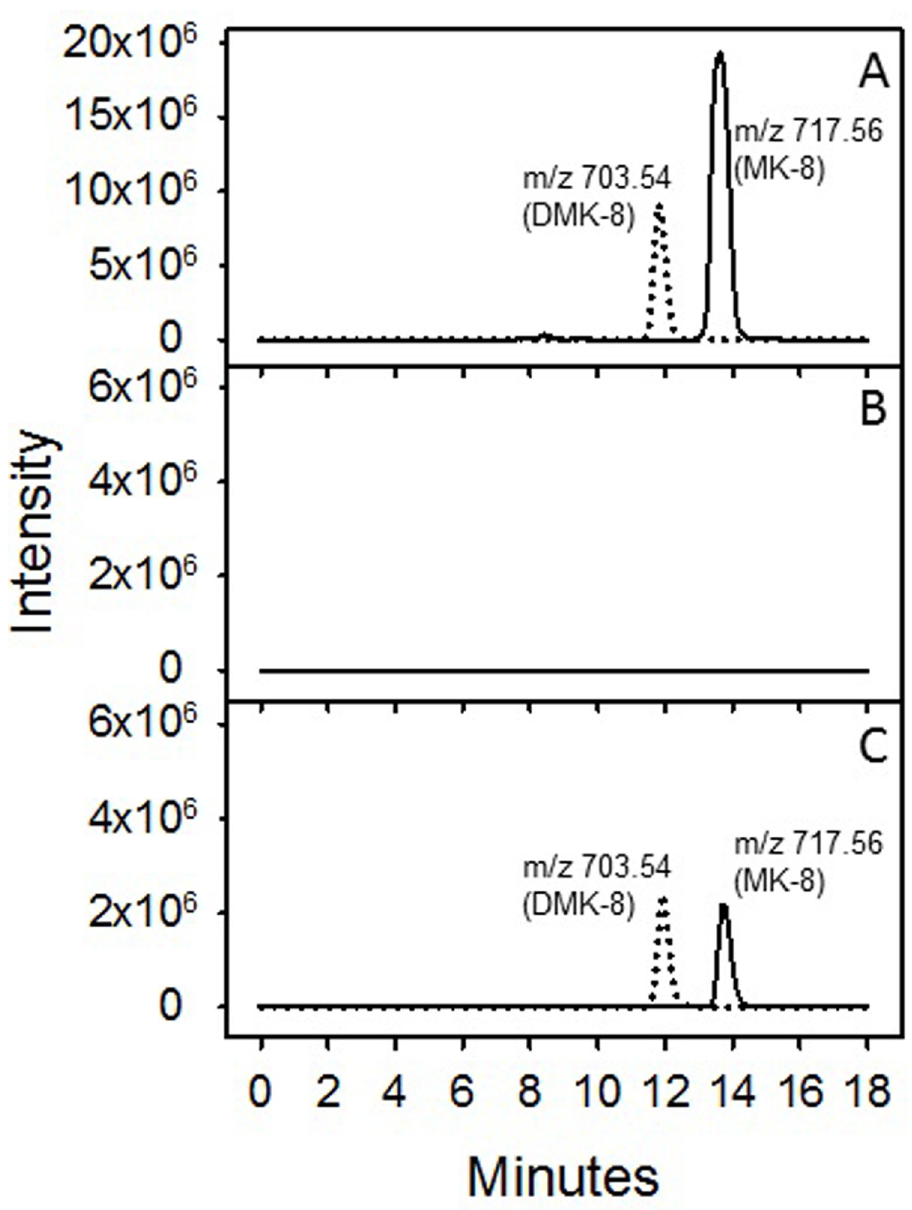
Fig 2. LC/MS analysis of neutral lipids. E . coli WT (CGSC # 7636) (Panel A), E . coli Δ menA (CGSC # 10816) (Panel B) and E . coli Δ menA (CGSC # 10816) complemented with pVV16:MenA (Panel C). Data shown are extracted ion chromatograms for m/z values of 703.54 (dotted line) and 717.56 (solid line), DMK-8 and MK-8, respectively.